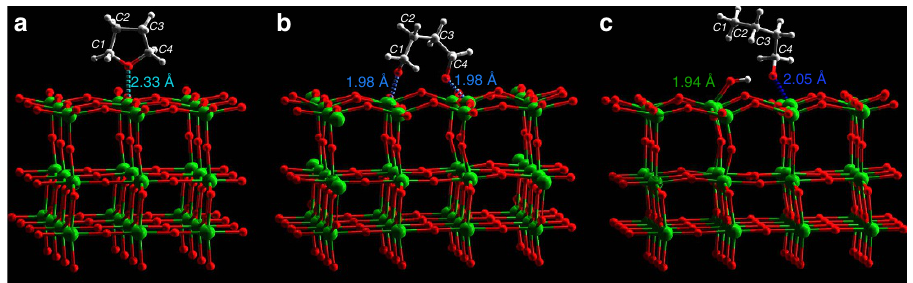
Figure 4 | View of the optimised structural models. ( a ) adsorbed THF, ( b ) reacted (ring-opened) THF and ( c ) 1-butanol after adsorption to generate 1-butanoxide and surface hydroxyl on the (001) plane of the catalyst Pt/Nb 2 O 5 (Nb: green; O: red; C; grey;